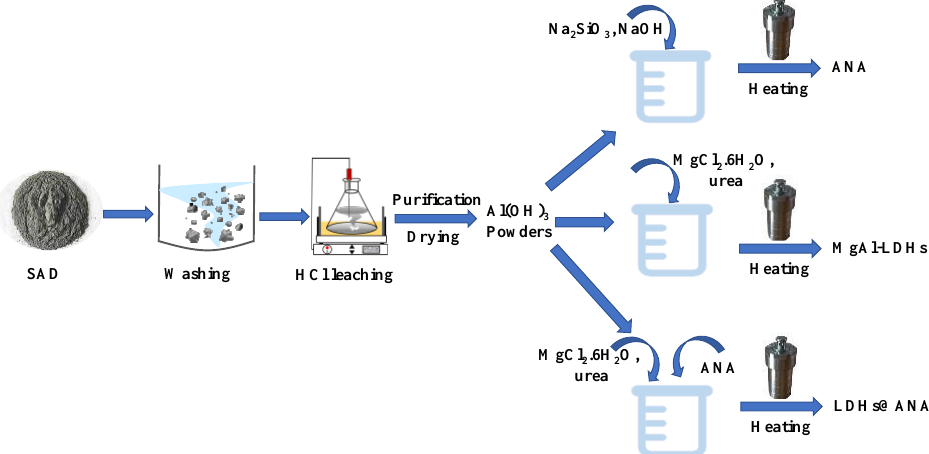
Figure 1. The fabrication process of the preparation of ANA, MgAl-LDHs, and LDHs@ANA.